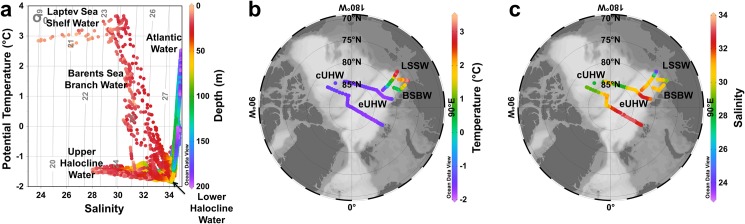
Hydrography in the surface central and eastern Arctic Ocean.(a) T-S diagram with depth (m) as color bar. Surface distribution of temperature (°C) (b) and salinity (c) with the approximate occupation of the water masses with the PML within the study region. Produced with Ocean Data View [44].